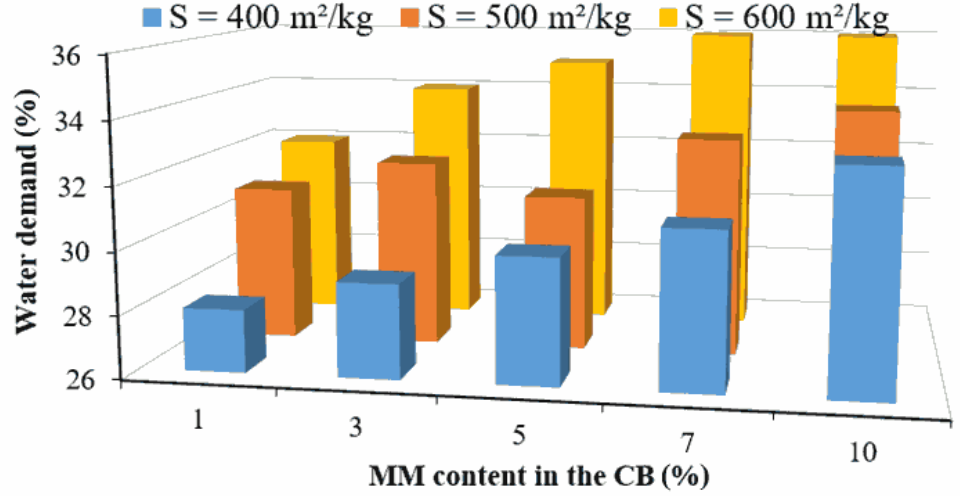
Figure 5. Dependence of the water demand of the mix on the MM1 amount and its specific surface.